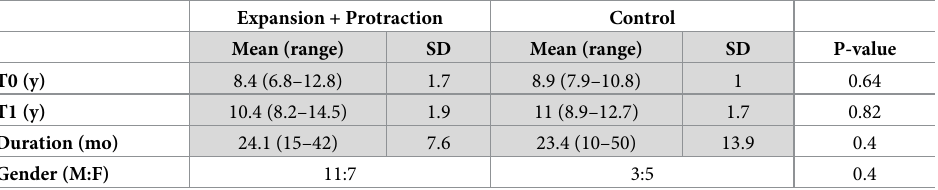
Table 1. Comparison of age, treatment duration, and gender distribution of sample sets in both groups. Expansion +